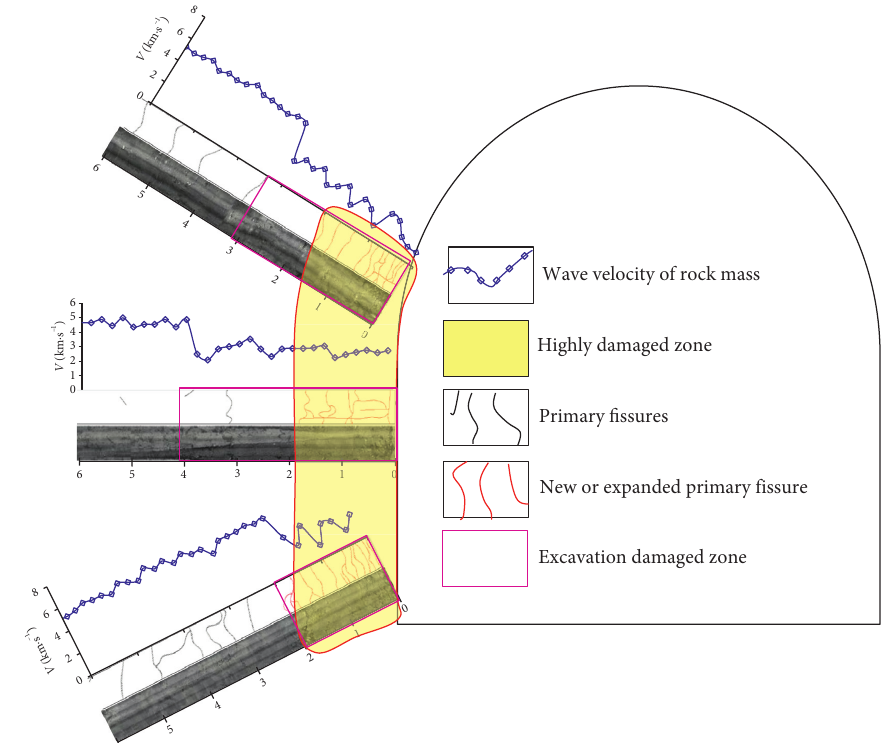
Figure 7: Test results of boreholes at different angles in jointed rock